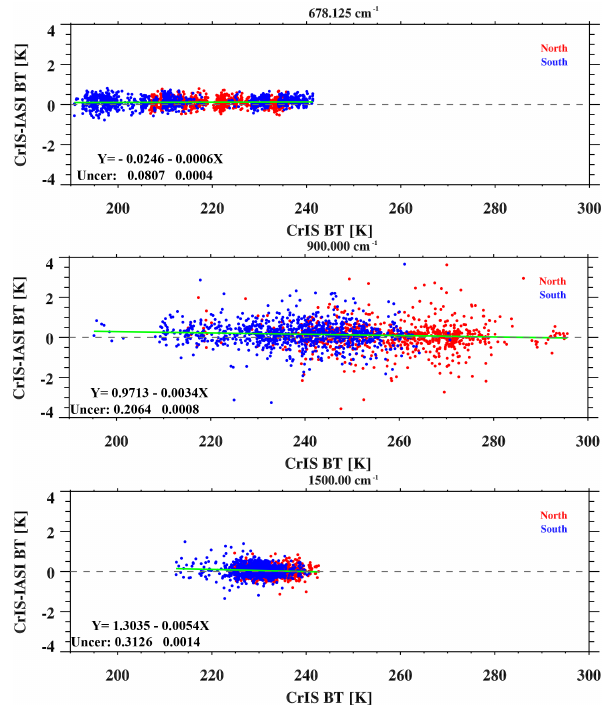
Figure 12. Same as Fig. 11 but for